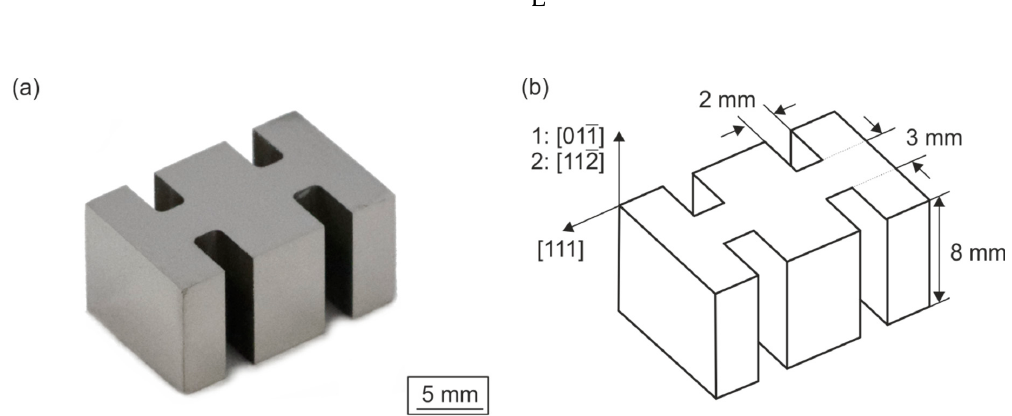
Figure 1. Double shear creep specimen. ( a ) Specimen after manufacturing. ( b ) Schematic drawing showing specimen dimensions and the shear